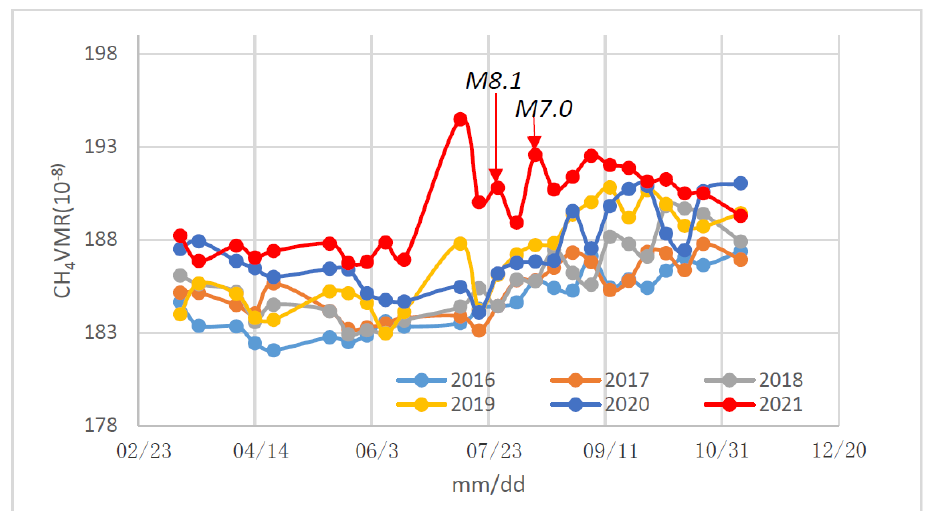
Figure 7. The CH4 volume mixing ratio value (VMR) variation over the 29 July 2021 M 8.1 and 14 August M 7.0 Alaska EQs.